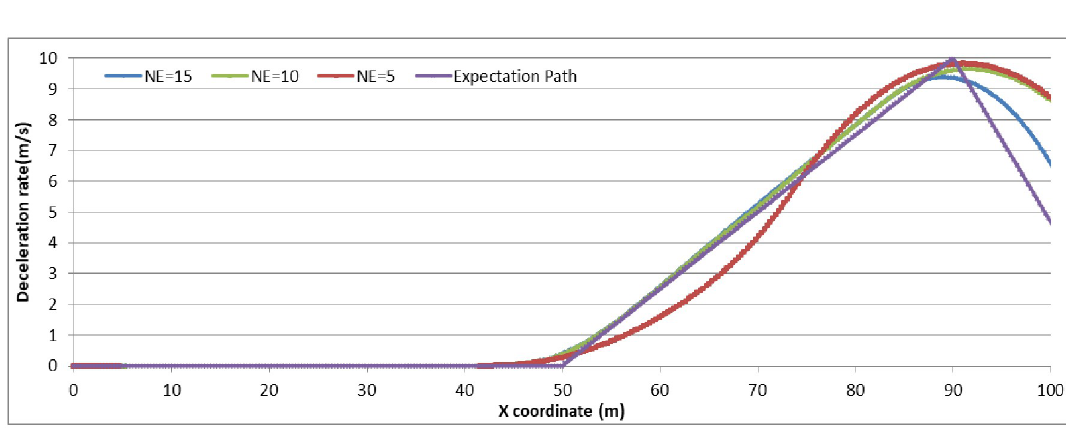
Fig 7. The B-Class vehicle driving trajectory for different N E (Group 1).